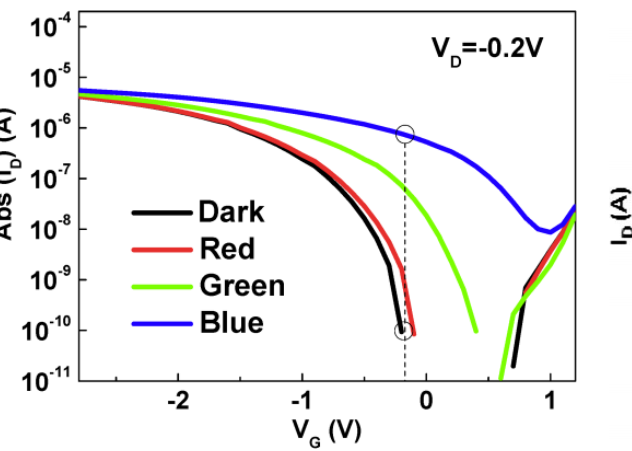
layer were performed by the first-principles calculation us- ing density functional theory by Chiu et al. in 2017 [72]. The p-type SnO TFT without the oxygen plasma treatment ex- x hibited an I /I of 4.25×10 3 , a µ of 6.11 cm 2 V −1 s −1 on FE off and a V of −0.32 V. With the oxygen plasma treatment on th the SnO channel layer, excess reacted oxygen was incor- x porated to the channel, leading to n-type operation. For the SnO, the energy proximity of the Sn 5s and O 2p states results in equal contributions to the VB edge. However, for the SnO , the CB is predominated by the Sn 5s orbitals and 2 the VB by the O 2p orbitals. The first-principles